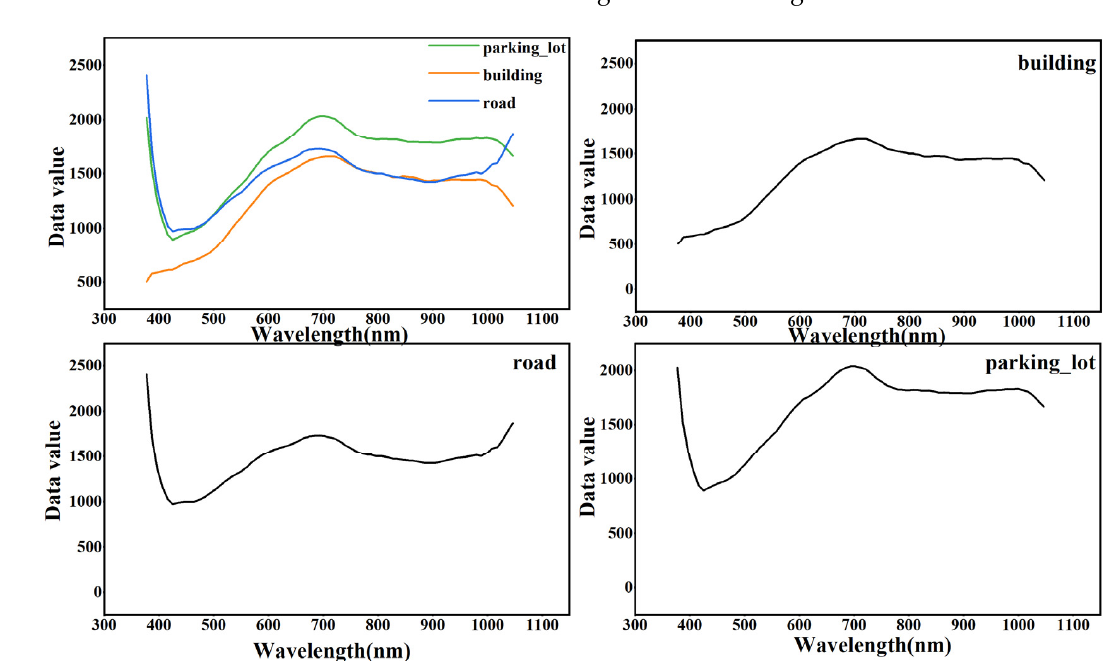
Figure 12. Spectral curves of classes with commission and omission error on Surrey